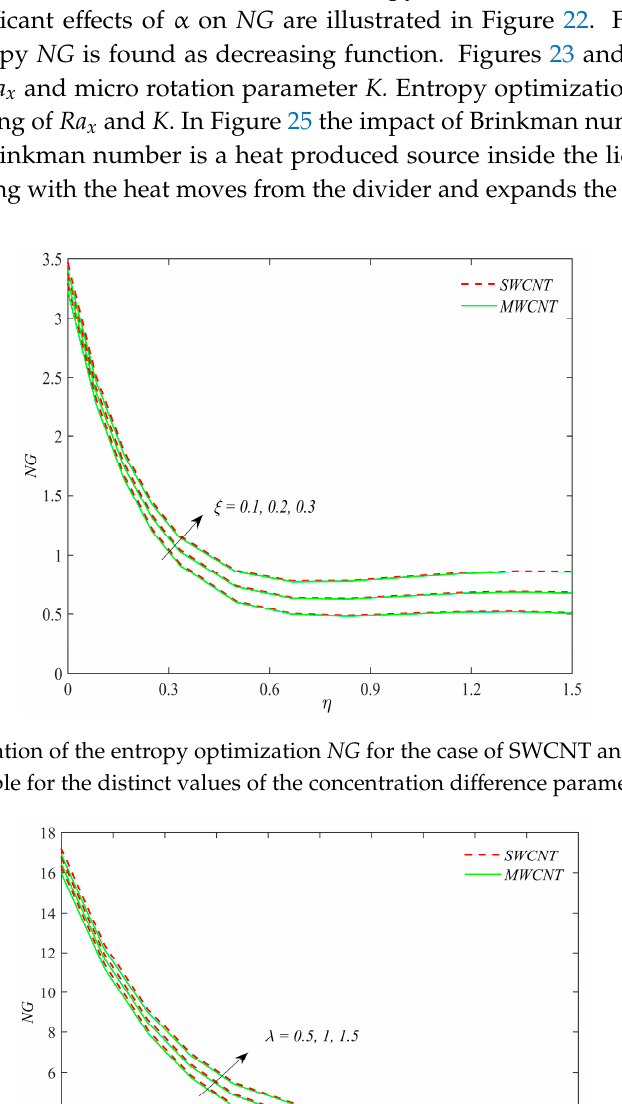
Figure 22. The variation of the entropy optimization NG for the case of SWCNT and MWCNT versus the similarity variable for the distinct values of the temperature difference parameter α .